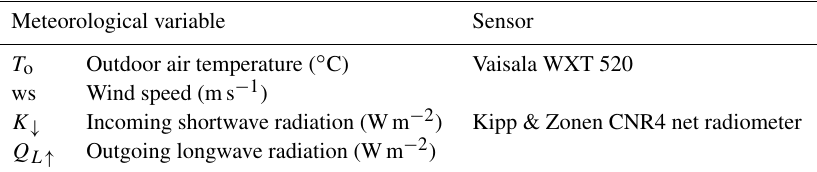
O C movement and travel through time (6 consecutive days) within each a N for each age group for three day types (week- S day – school/non-school, weekend) as a result of A N occu- pant exchange (Sect. 2.2). The occupancy levels vary by day type and between age groups, whilst having general consis- tency within day type by age cohort. Note, people travel out- side (and into) this B during the period, but no perturbation is